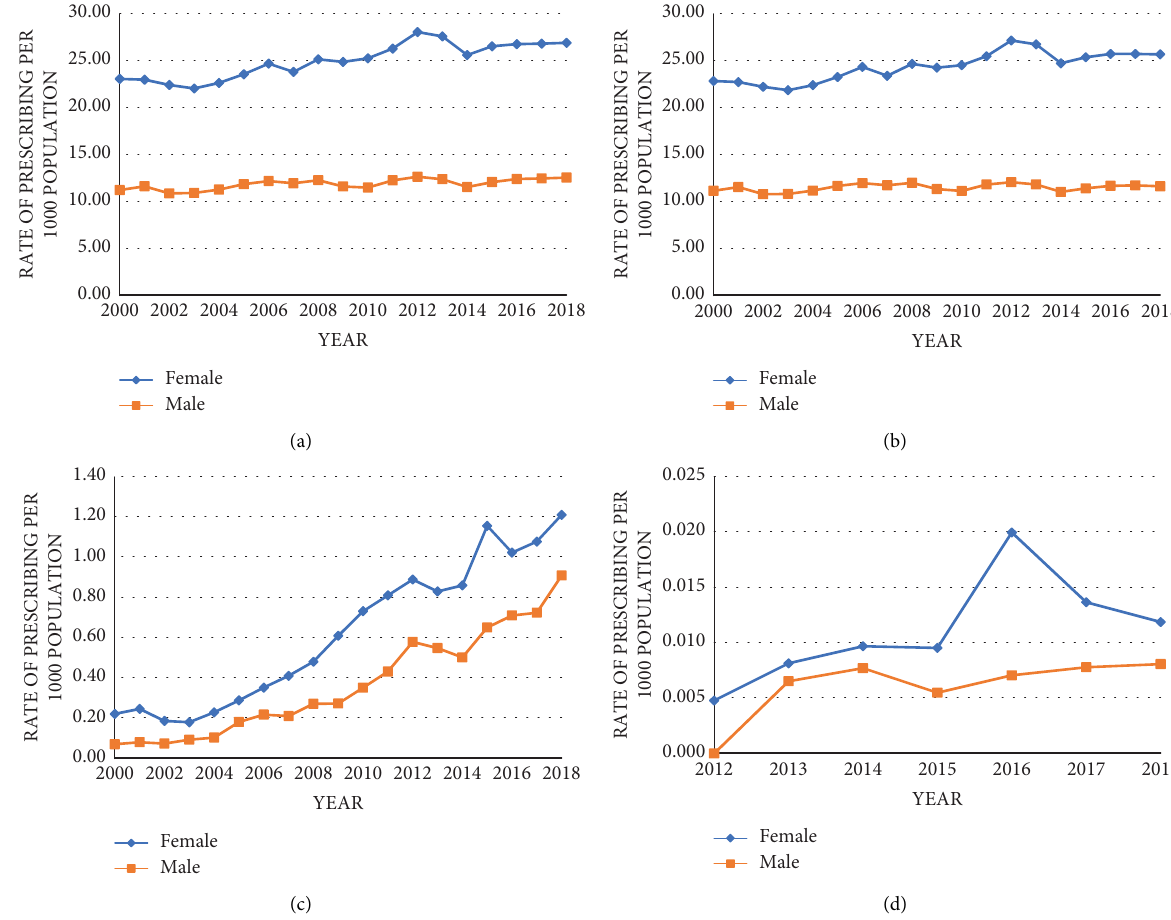
Figure 3: Rate of total oral CDI-indicated antibiotic prescribing and by individual antibiotic, stratifed by sex, in British Columbia, 2000–18: (a) shows the rate of total antibiotic prescribing for each sex; (b–d) show the rate of rate prescribing for metronidazole, vancomycin, and fdaxomicin, respectively, for each sex. Table 2: Percentage of CDI-indicated antibiotics linked to the outpatient (ICD-9 diagnostic code “008”) database and the discharge (hospital) database (ICD-10 diagnostic code “A04.7”) throughout the entire study period, 2000–18. Type of antibiotic